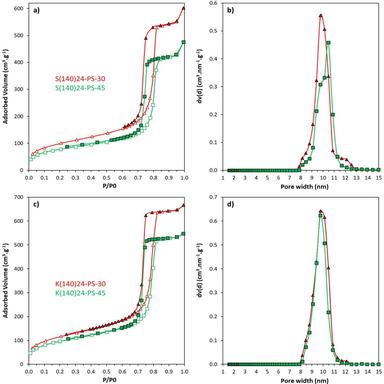
N2 at 196 C physisorption isotherms and corresponding NLDFT desorption pore size distributions of S(140)24-PS (a,b) and K(140)24-PS (c,d) composite materials.